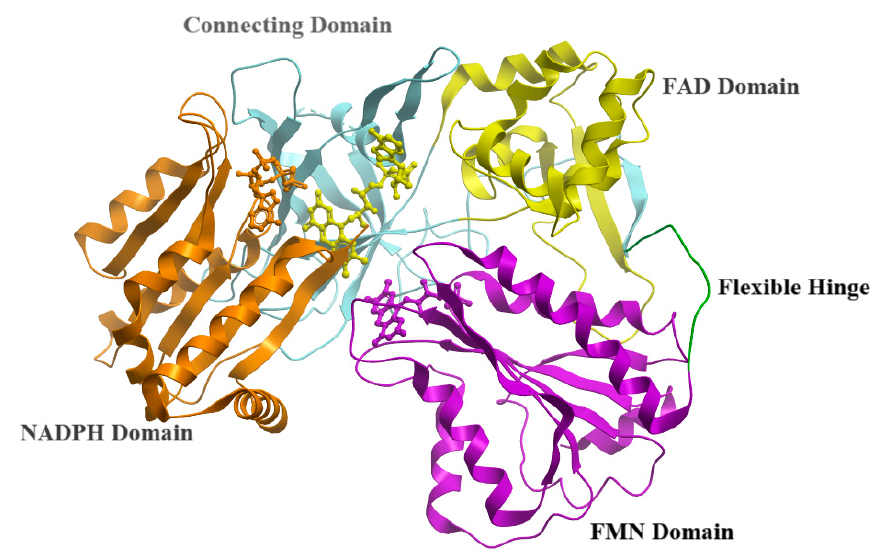
Figure 3. Ribbon model of human wild-type POR protein structure (PDB: 5FA6), displaying the flexible hinge region (green) and the three cofactor binding domains, i.e., FMN (purple ribbon), FAD (yellow ribbon), and NADPH (orange ribbon). The FMN, FAD, as well as NADPH ligands, are indicated as balls and sticks with colors corresponding to their binding domains (purple, yellow, and orange, respectively).